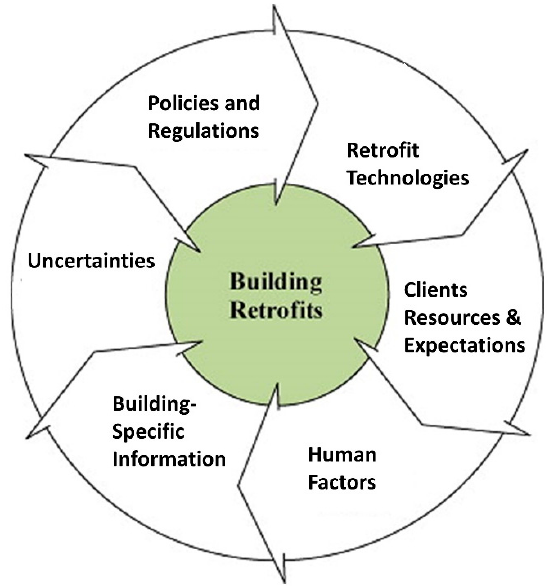
Figure 9. Key factors affecting building retrofit packages (adapted with permission from Ma et al. [16]).